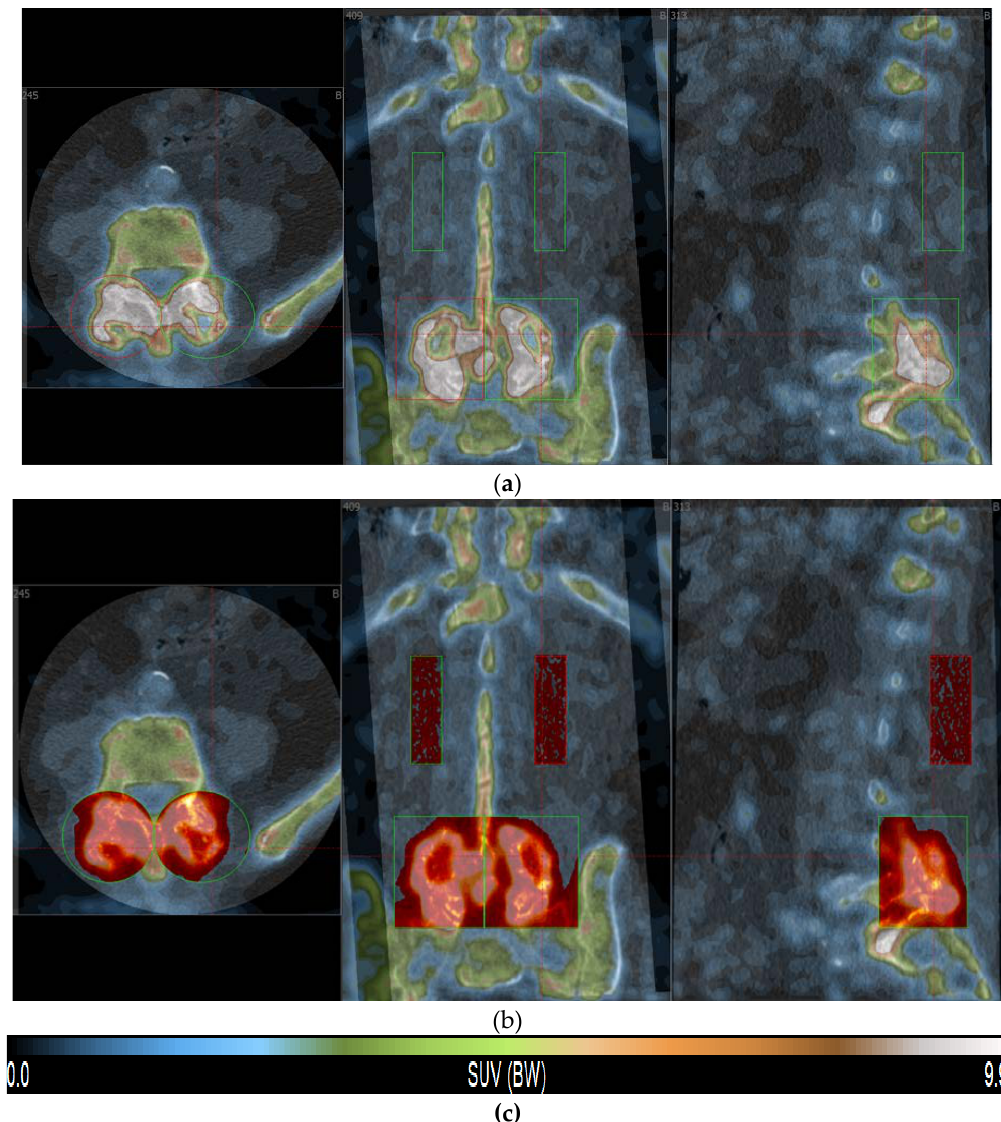
Figure 1. Triplane view of a 90-min NaF-PET / CT scan. The green and red markings denote VOI size and placement. Segmented voxels have a red color overlay. ( a ) Empty VOIs, before segmentation. ( b ) VOIs after segmentation. (c) PET SUV color